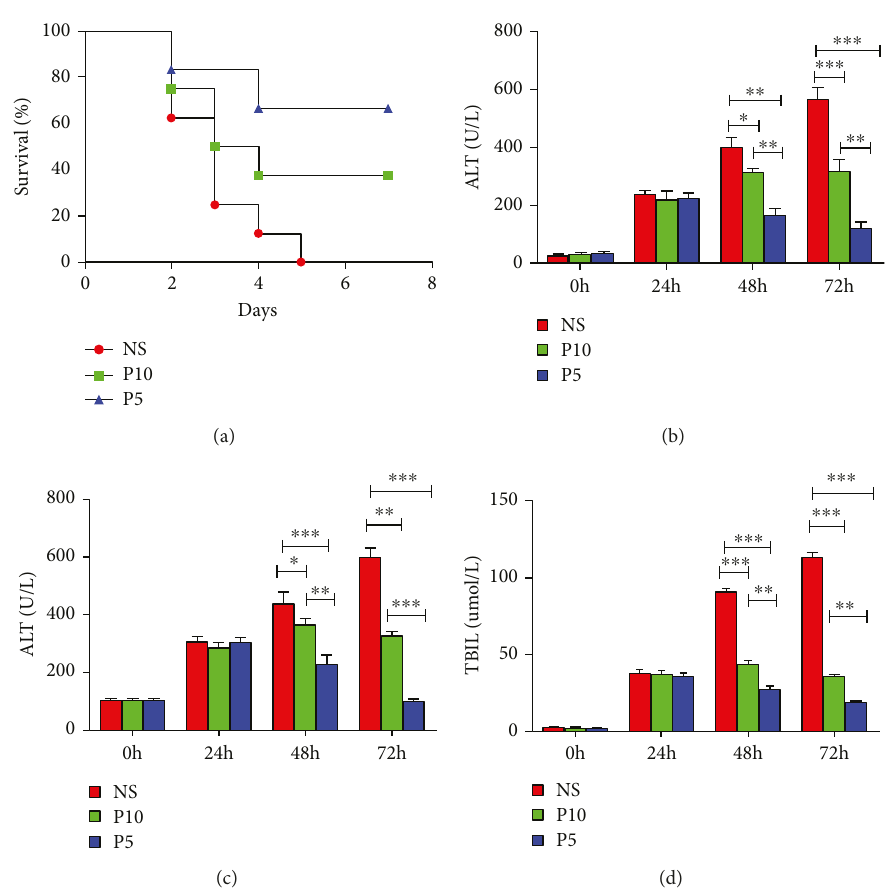
Figure 2: E ff ects of hUC-MSC transplantation on the survival rates and liver function in ALF rats. A total of 36 rats were randomly divided into three groups: P5 hUC-MSCs group, P10 hUC-MSCs group, and NS group ( n = 12 per group). D-GalN/LPS were administered to rats intraperitoneally to induce ALF. 24 h later, the P5 hUC-MSCs and P10 hUC-MSCs (dose: 1.0 × 10 7 cells/kg/mL) were transplanted, respectively, while the NS group was given 1 mL normal saline. The blood samples were collected at 0 h, 24h, 48 h, and 72h post-D-GaIN/ LPS injection. (a) The survival rate in the P5 hUC-MSCs, P10 hUC-MSCs, and NS groups. Levels of serum (b) alanine transferase (ALT), (c) aspartate aminotransferase (AST), and (d) total bilirubin (TBil) in treatment of ALF rats. Data were expressed as mean ± SD. ∗ P < 0 05 , ∗∗ P < 0 01 , ∗∗∗ P < 0 001 . hUC-MSCs, human umbilical cord-derived mesenchymal stem cells; D-GalN, D-galactosamine; LPS,